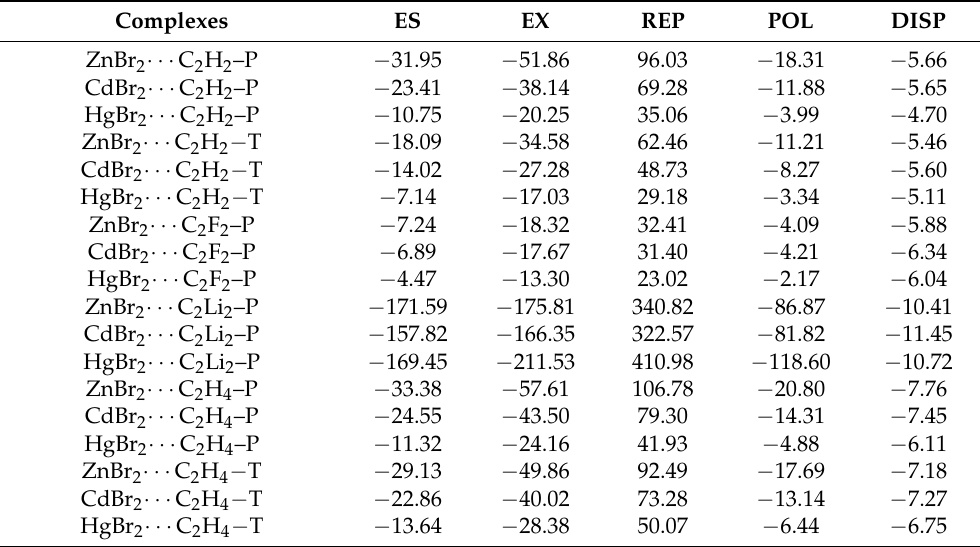
Table 4. Electrostatic energy (ES), exchange energy (EX), repulsion energy (REP), polarization energy (POL), and dispersion energy (DISP) in the selected complexes. All are in kcal/mol. Complexes ES EX REP POL